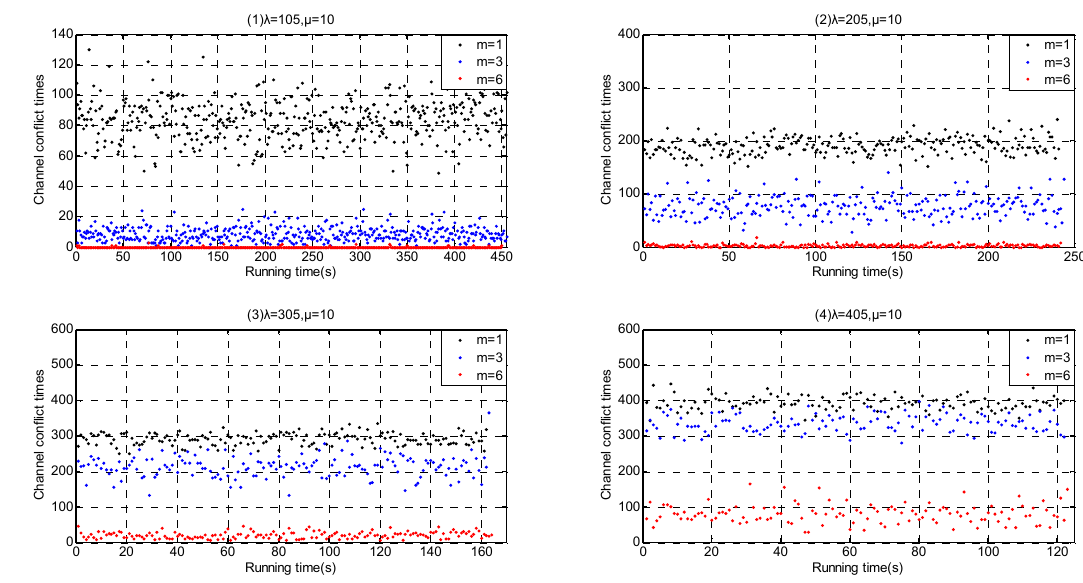
Figure 24. The times of channel conflicts in Service-independent